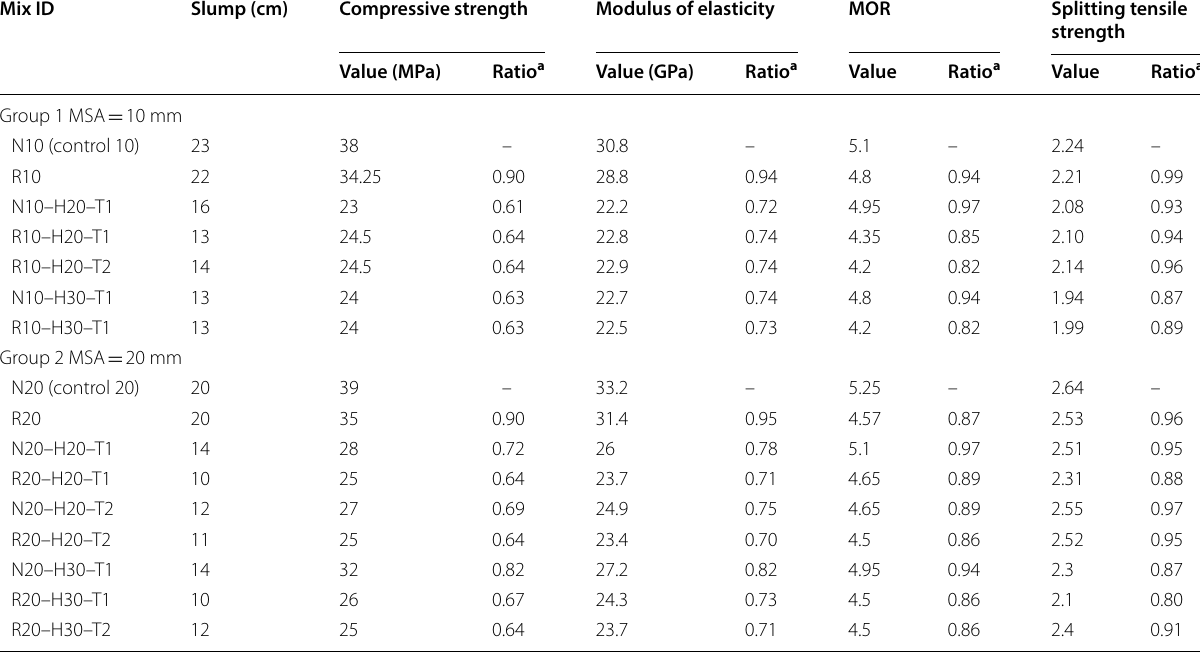
Table 6 Slump and mechanical properties of all